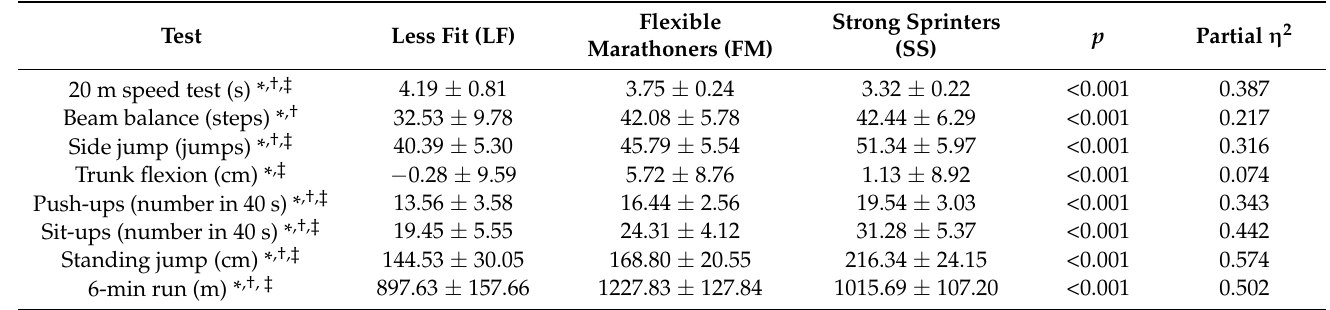
Table 3. Differences in physical fitness characteristics of the three clusters through one-way ANOVA with Tukey honestly significant difference post hoc